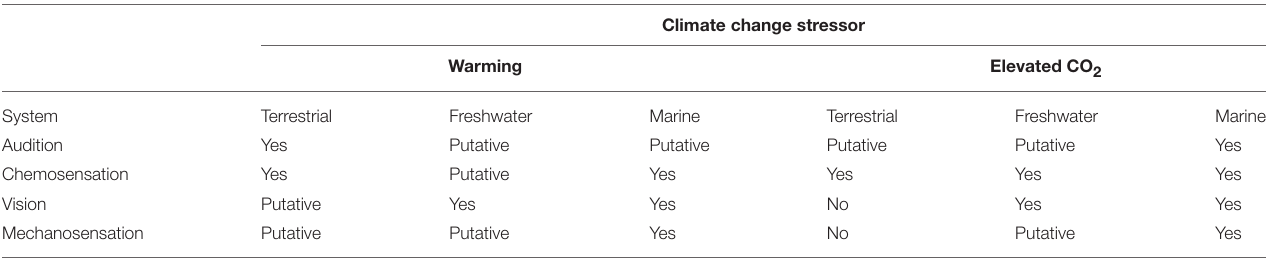
TABLE 3 | Summary of impacts of climate change stressors on sensory systems.